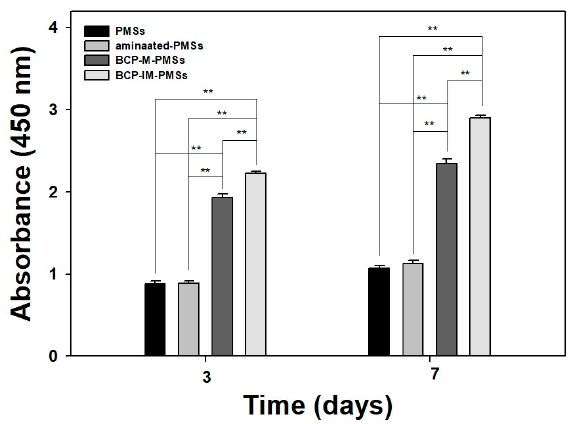
Figure 3. Proliferation of MG-63 cells cultured on PMSs, aminated-PMSs, BCP-M-PMSs, or BCP-IM- PMSs for 3 or 7 days ( n = 5) (* p < 0.05 and ** p < 0.01).